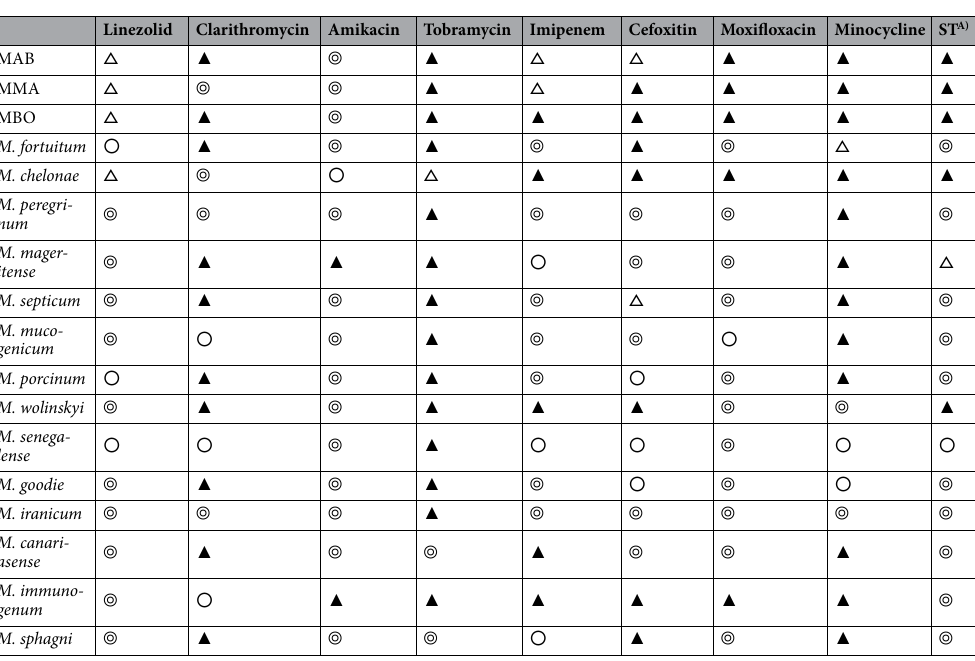
Table 4. Characteristics of antimicrobial susceptibility of rapidly growing mycobacteria (RGM) species. ◎ Susceptible isolates > 75%, 〇 Susceptible isolates 51% ‒ 75%, △ Susceptible isolates 25% ‒ 50%, ▲ Susceptible isolates < 25% A)